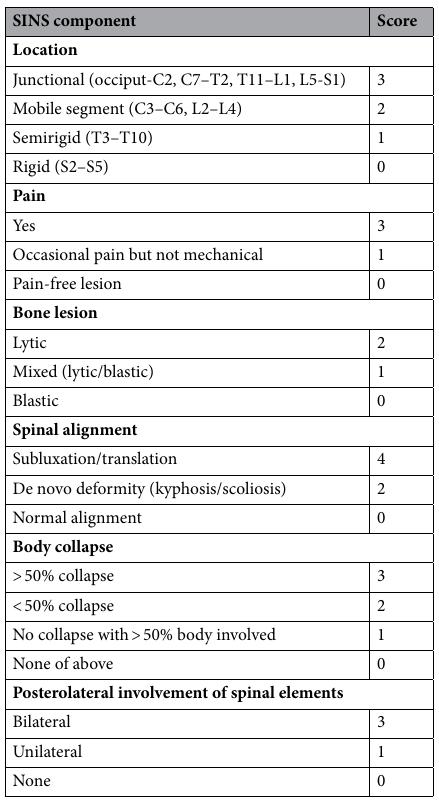
Table 1. Spinal instability neoplastic score (SINS). Binary scale (0–6, stable; 7–18, unstable). Tertiary scale (0–6, stable; 7–12, potentially unstable; and 13–18,